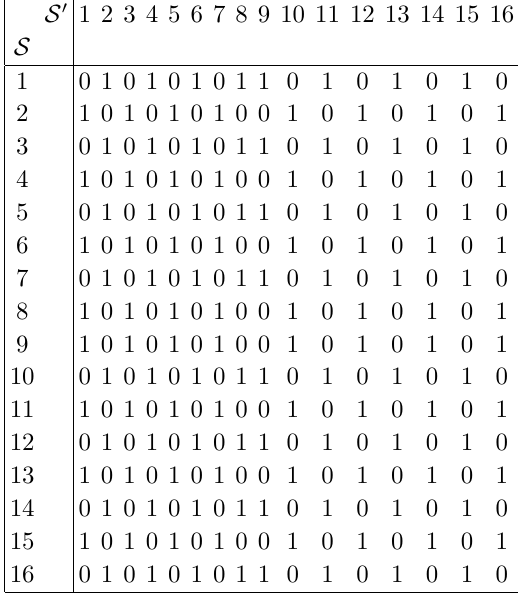
(cid:2) P with di(cid:11)erent boolean factors. [1] [6]